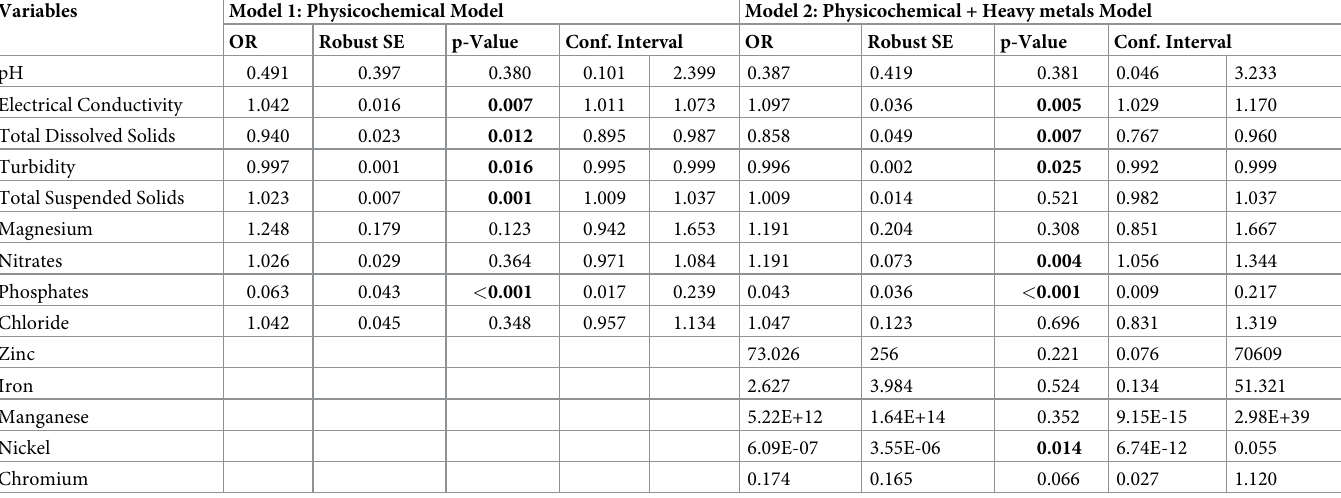
Table 6 is a nested model showing the multivariate relationship between faecal coliform, physi- cochemical and heavy metal concentrations in ground water. Higher values of total dissolved Table 6. Multivariate negative log–log regression model predicting detection of faecal coliform in groundwater.